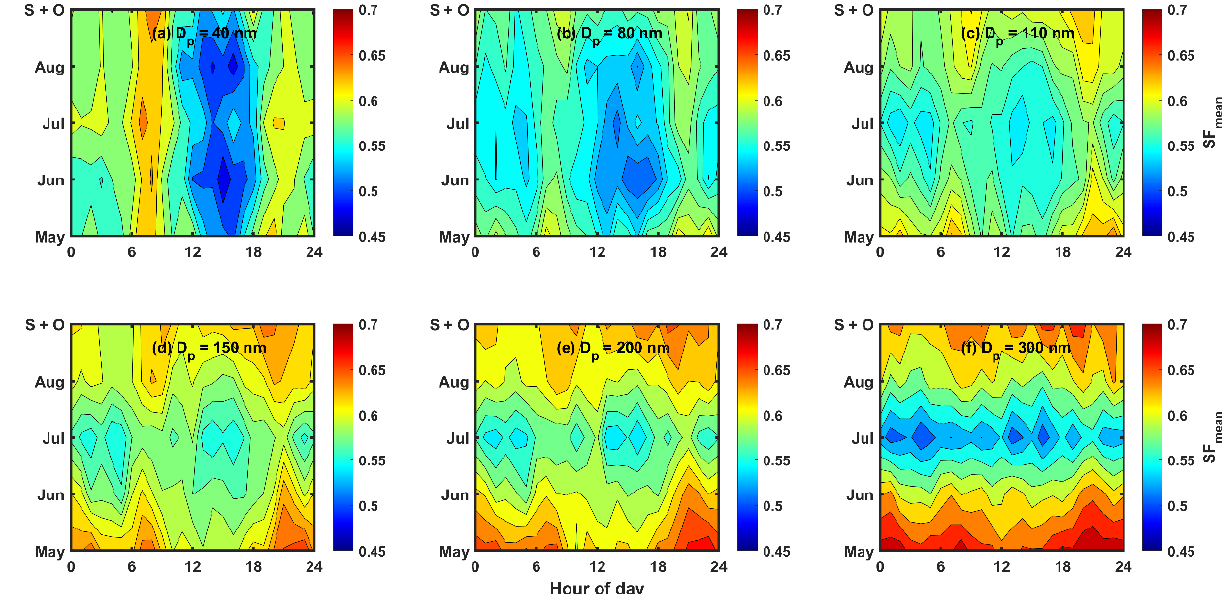
Figure 8. Diurnal variations in ensemble mean shrink factor (SF mean ) in different months for different particle